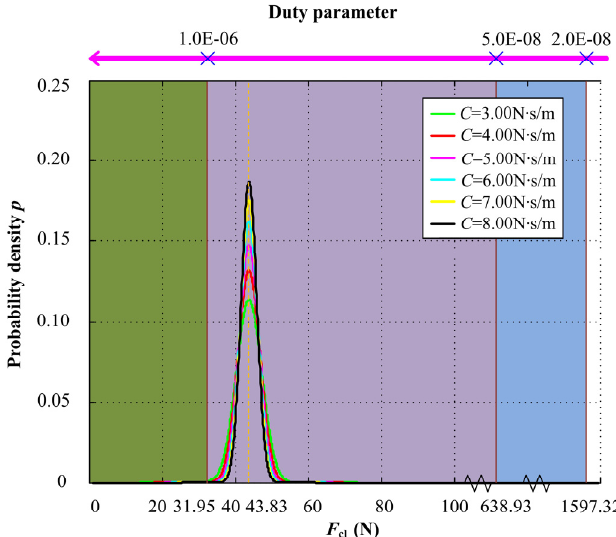
Figure 10. Probability density of closing force F cl under di ff erent axial damping and the relationship with duty parameter G.